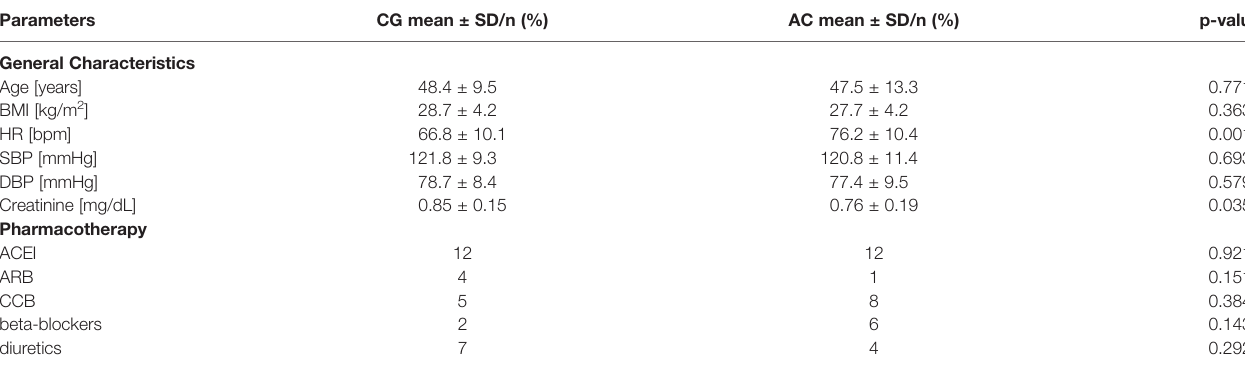
TABLE 3 | Comparative analysis of the general characteristics of the control group (CG) and the acromegaly (AC) group. Parameters